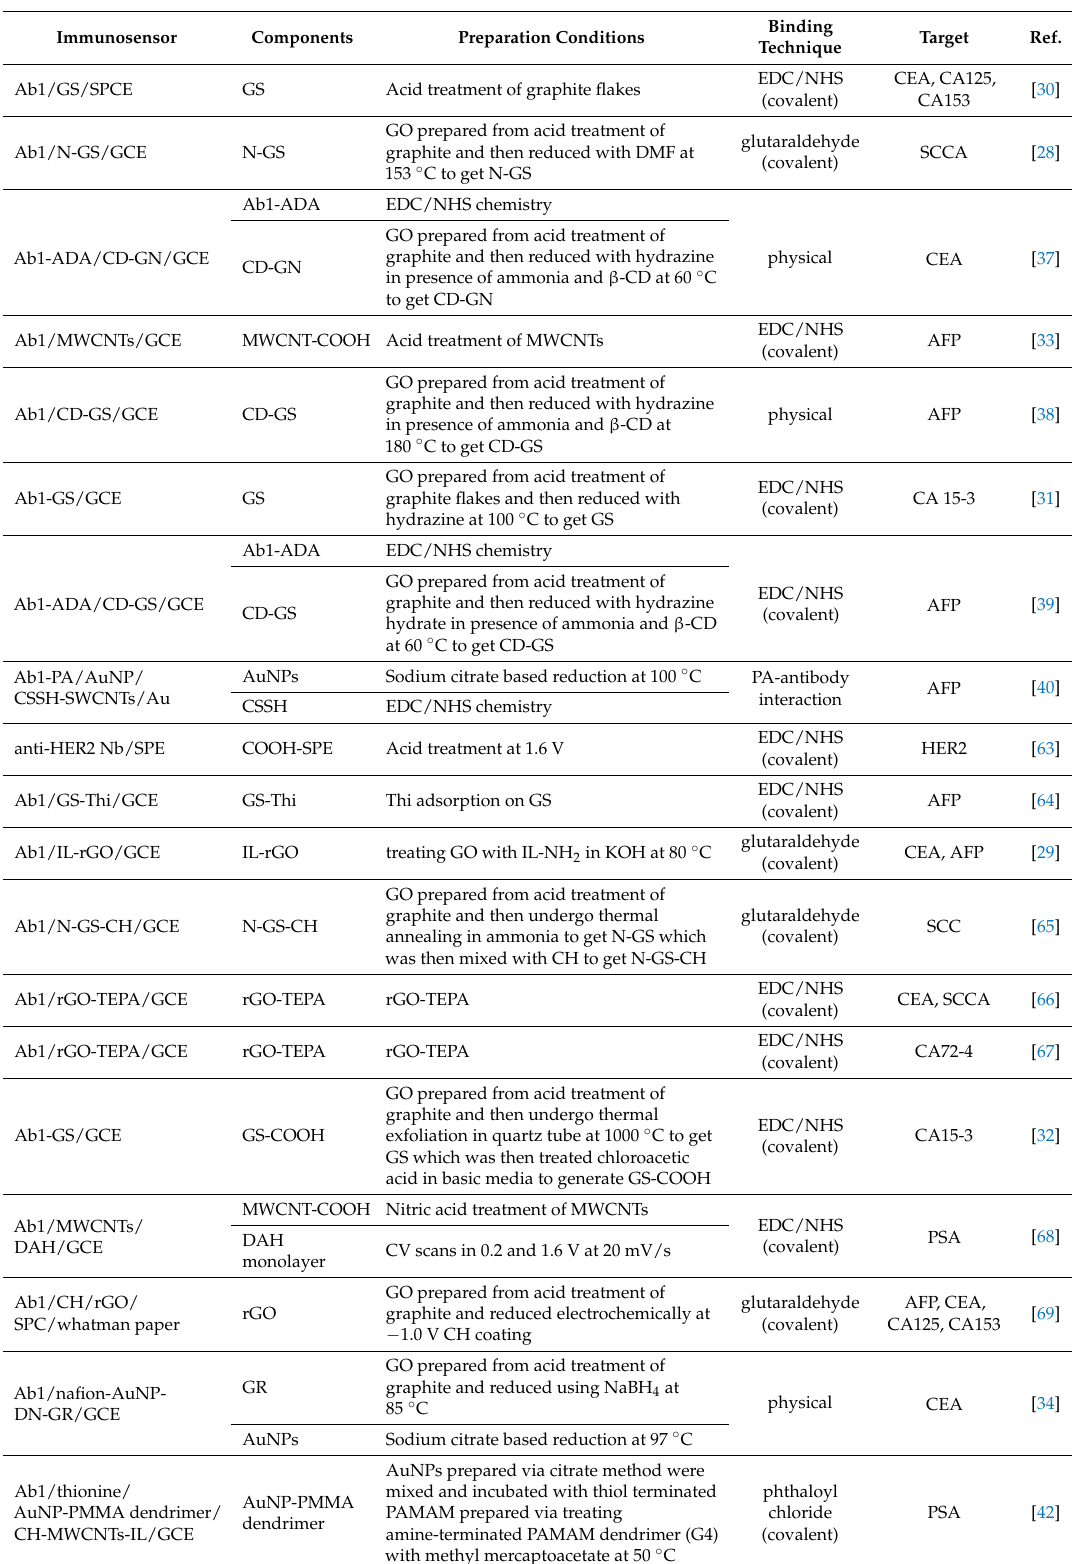
Table 1. Various immunosensors and their preparation